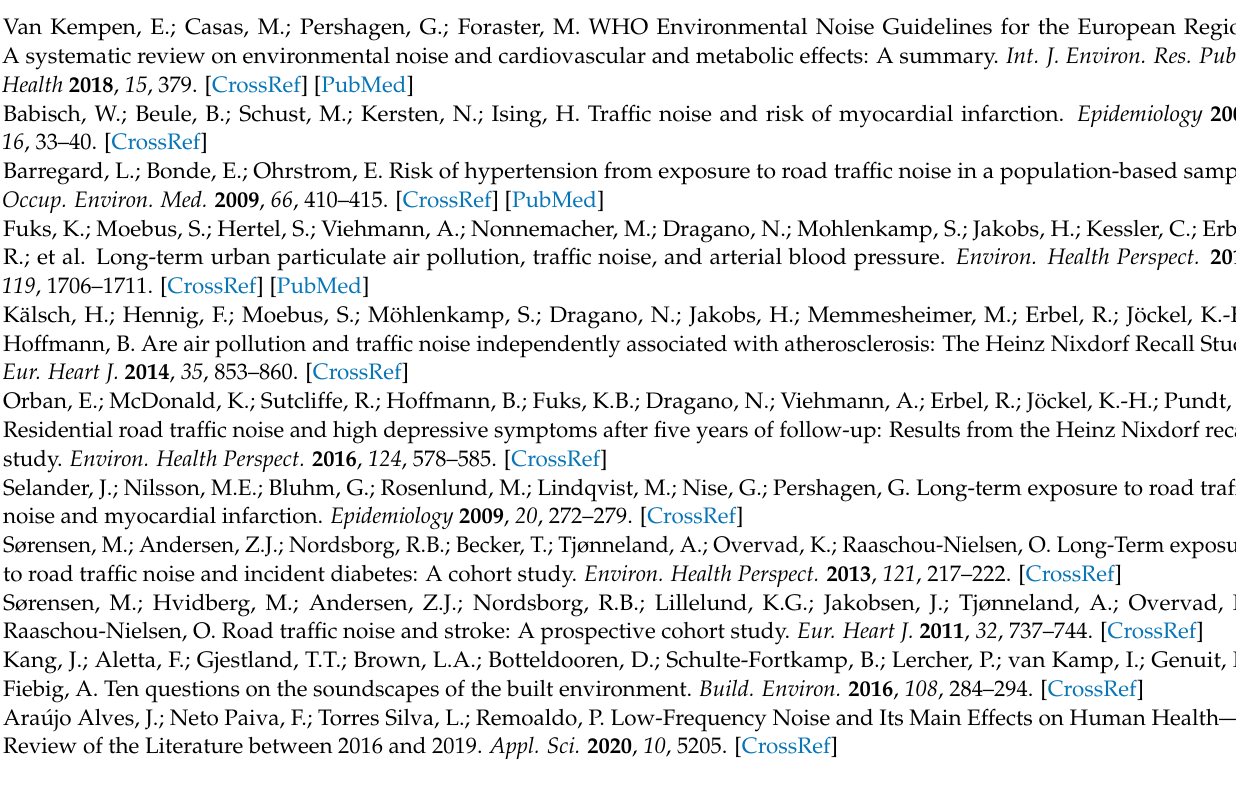
Figure A2. Sound source examples and their corresponding correlation matrices. A spectrogram was calculated for the corresponding audio recording. Then, power of all frequency bins were correlated over time for the period in which the sound source occurred. The Z-axis represents the Pearson correlation coefficient. The insert shows the distribution of all correlation values of the respective correlation matrix.